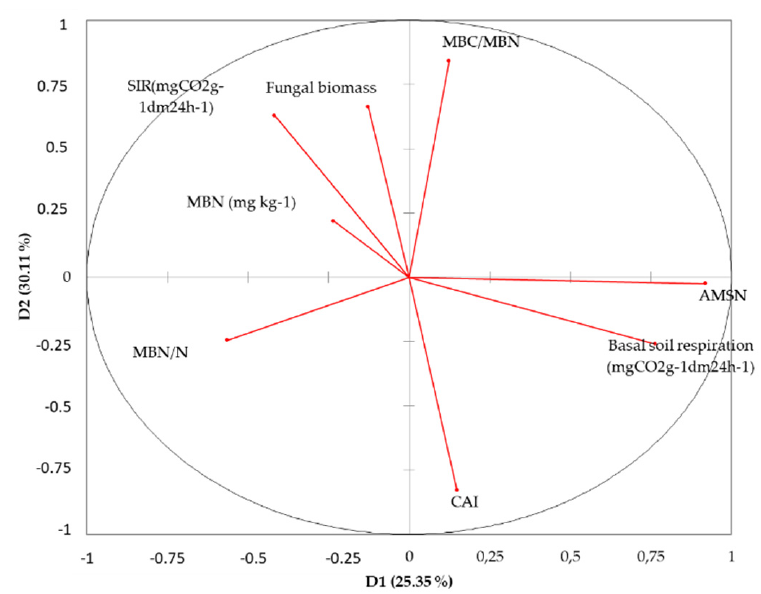
Figure 5. Varimax rotation biplot for soil biological characteristics.